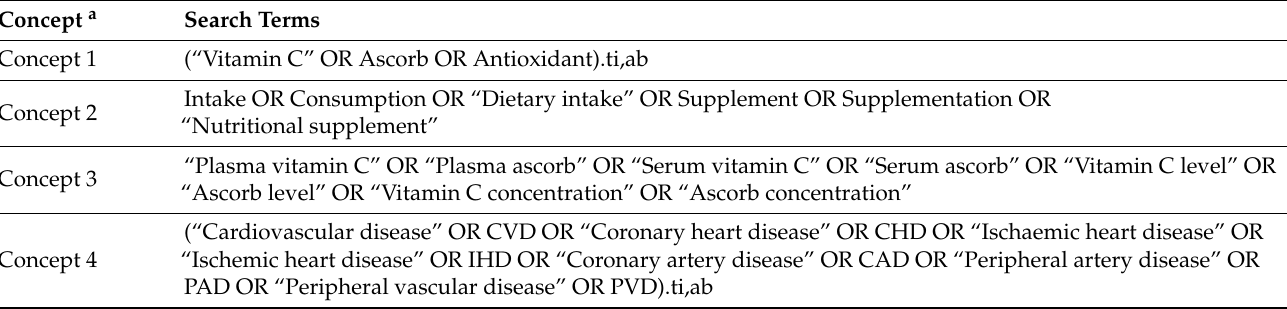
Table 1. Full details of the search terms used across databases.